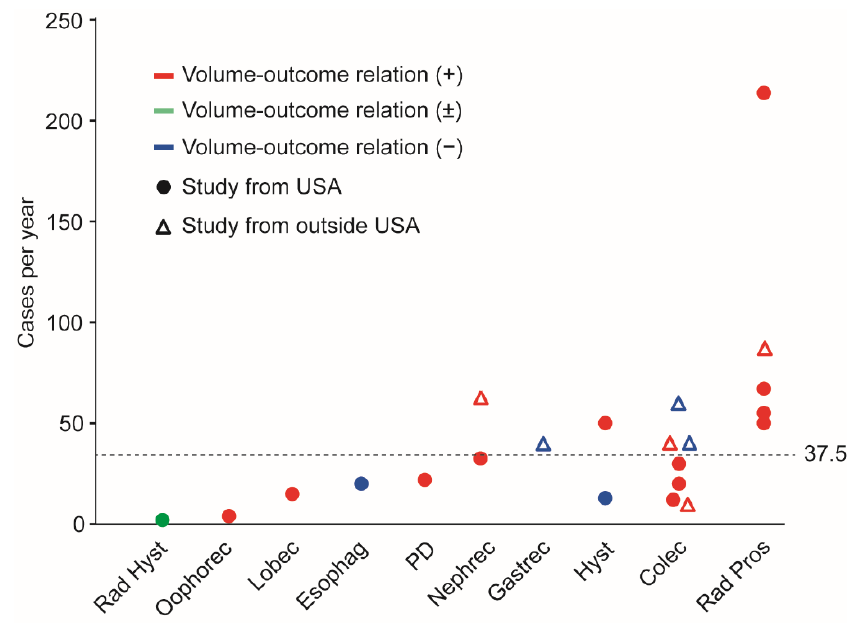
Figure 2. Association between annual hospital surgical cases and volume–outcome. The association between the hospital annual cases of minimally invasive surgery and perioperative outcomes is shown. The median number of annual cases was 37.5. Red indicates the observed volume–outcome association. Green indicates that the volume–outcome association was inconsistent. Blue indicates that the volume–outcome association was not observed. Abbreviations: USA, United States of America; Rad Hyst, radical hysterectomy; oophorec, oophorectomy; lobec, lobectomy; esophag, esophagectomy; PD, pancreaticoduodenectomy; nephrec, nephrectomy; gastrec, gastrectomy; hyst, hysterectomy; colec, colectomy; and Rad Pros, radical